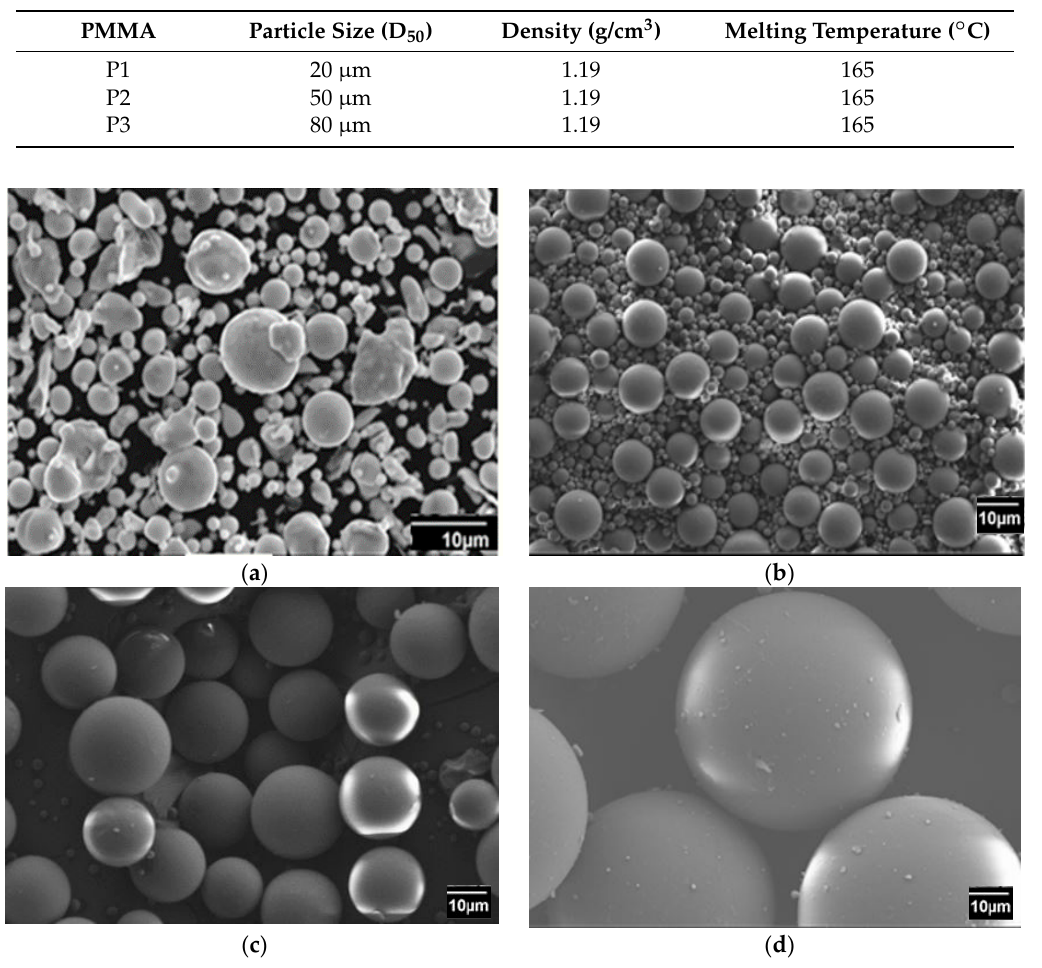
Figure 1. Scanning electron microscope photographs of ( a ) SUS 316L powder; ( b ) polymethyl methacrylate (PMMA) space holder: 20 μ m; ( c ) PMMA space holder: 50 μ m; and ( d ) PMMA space holder: 80 μ m .